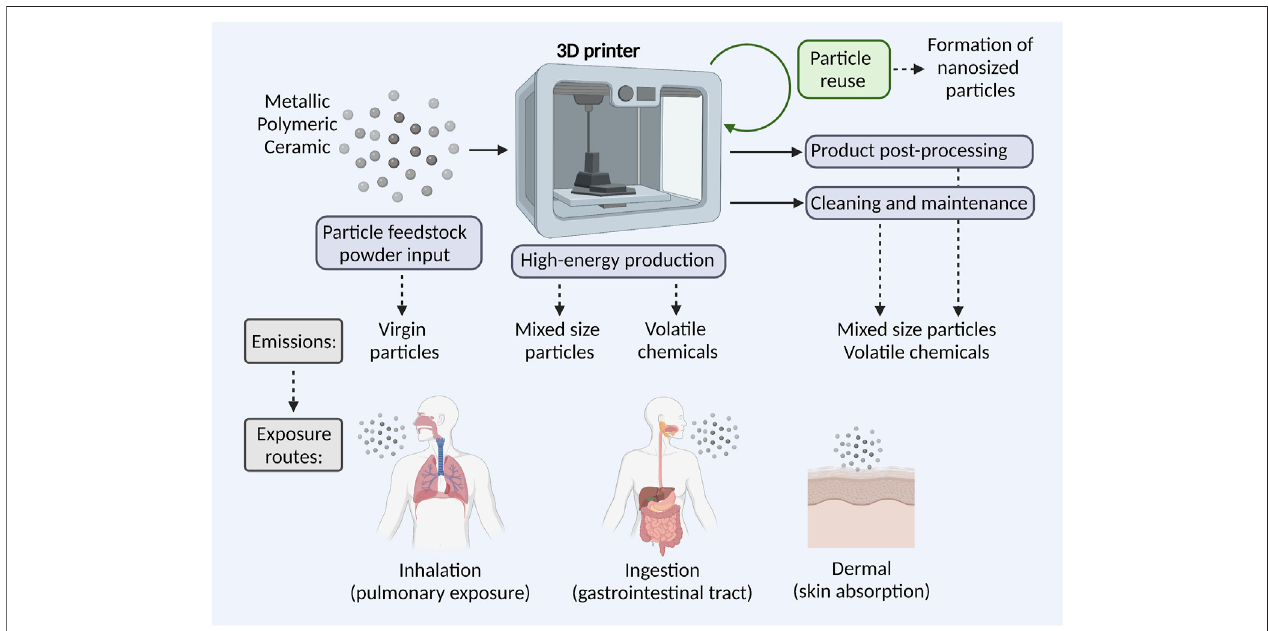
FIGURE 3 | Particle and chemical exposure risks in AM. At different stages of the AM process chain particle and chemical emissions may occur, including input of feedstockpowders,high-energyproduction,productpost-processing,machinecleaning,andmaintenance.PotentialparticleexposureroutesforexposedAMworkers involve inhalation, ingestion, and skin